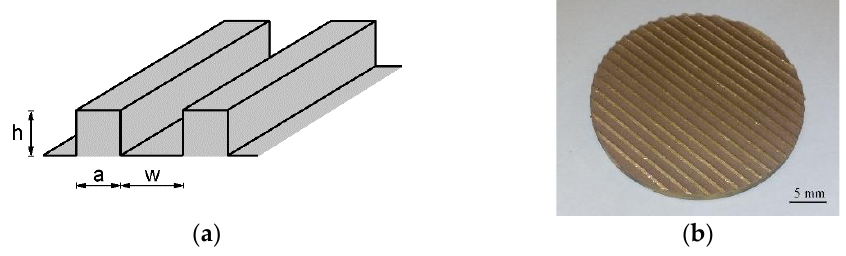
Figure 1. A selected laser-treated sample: ( a ) schematic drawing and ( b ) photo. The magnified image of the parallel grooves and the bottom microstructure is shown in Figure 2.